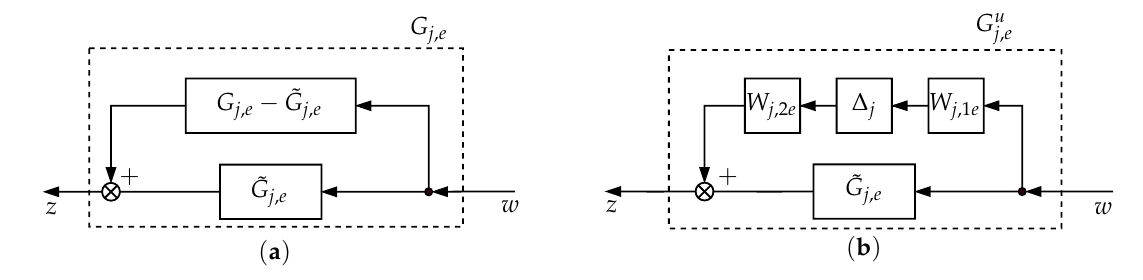
Figure 15. Uncertainty refinement — calculating the scaled frequency weighting filter W j ,1 e : ( a ) Representation of the absolute error between the nominal scaled subsystem G j , e and the reduced order scaled subsystem ˜ G j , e . ( b ) Representing the absolute error as an additive uncertainty with the new refined frequency weighting filters W j ,2 e and W j ,1 e